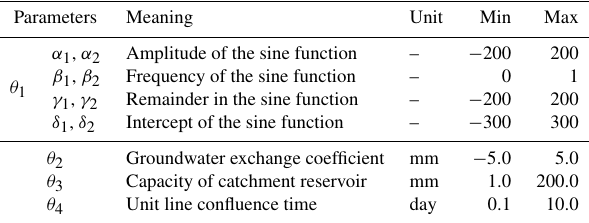
Table 3. Ranges of the initial values of GR4J model